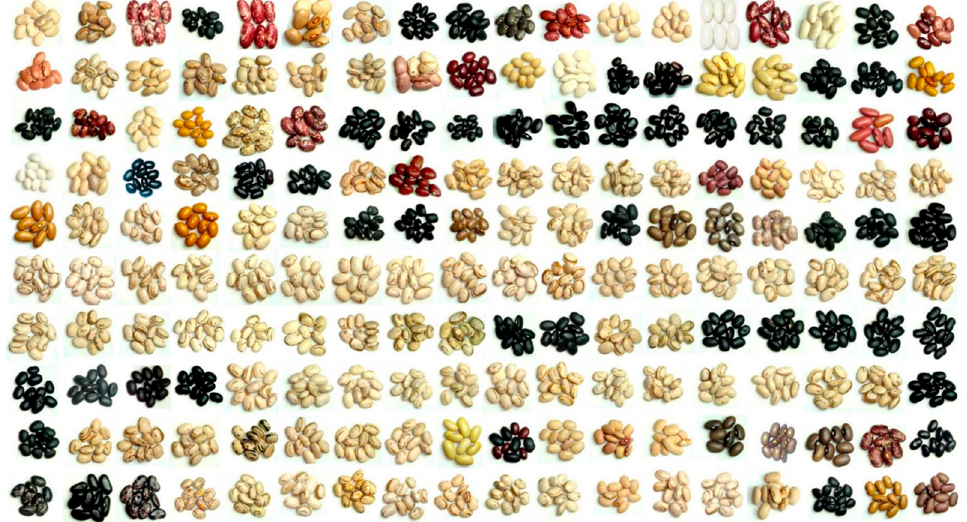
Figure 1. Phenotypic seed diversity encompassed by 180 accessions of a common bean panel.